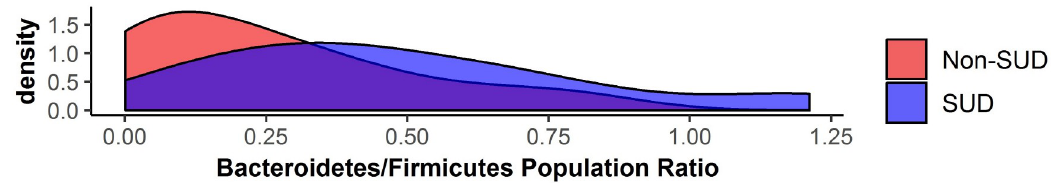
Fig 2. Density plot of the Bacteroidetes:Firmicutes (B:F) population ratio. Welch’s non-parametric t-test shows that those groups are significantly different in their B:F population ratios.